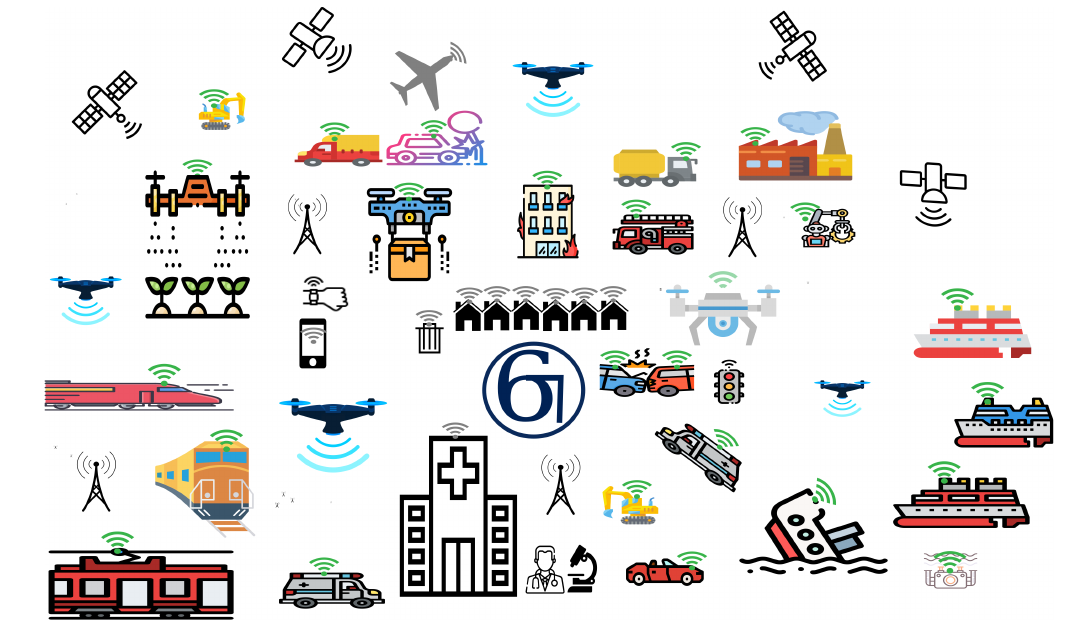
Figure 1. Envisioning the challenges of